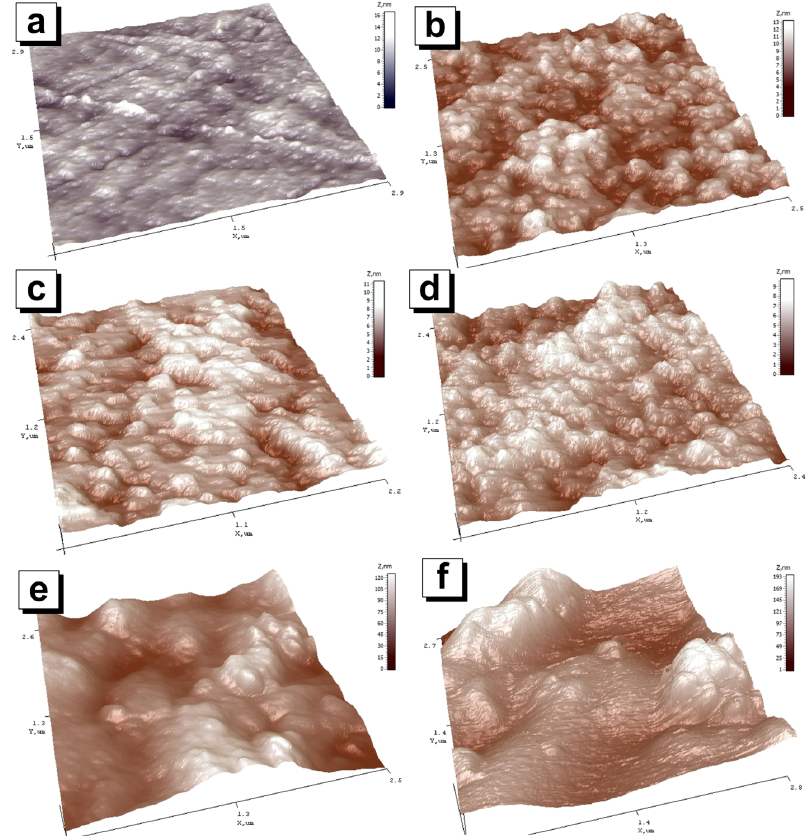
Figure 5. Three-dimensional images of ( a ) PVA matrix and “MZFA/PVA” nanocomposites with nanoparticle concentrations of ( b ) 2 wt.%; ( c ) 4 wt.%; ( d ) 6 wt.%; ( e ) 8 wt.%; and ( f ) 10 wt.%.